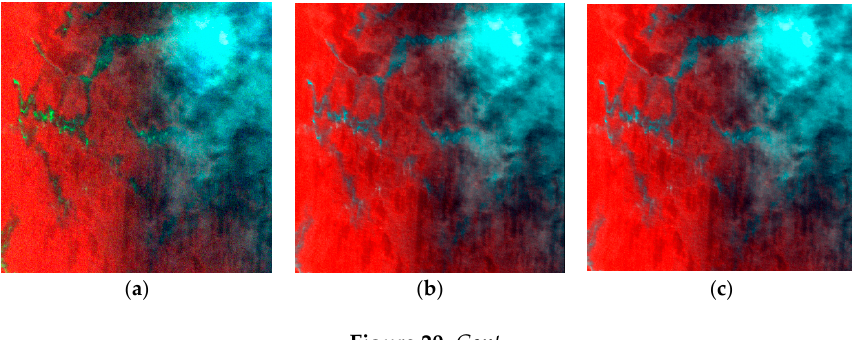
Figure 19. The abundance maps using RBSPP+MVSA. ( a ) oil ( b ) water; ( c ) cloud.